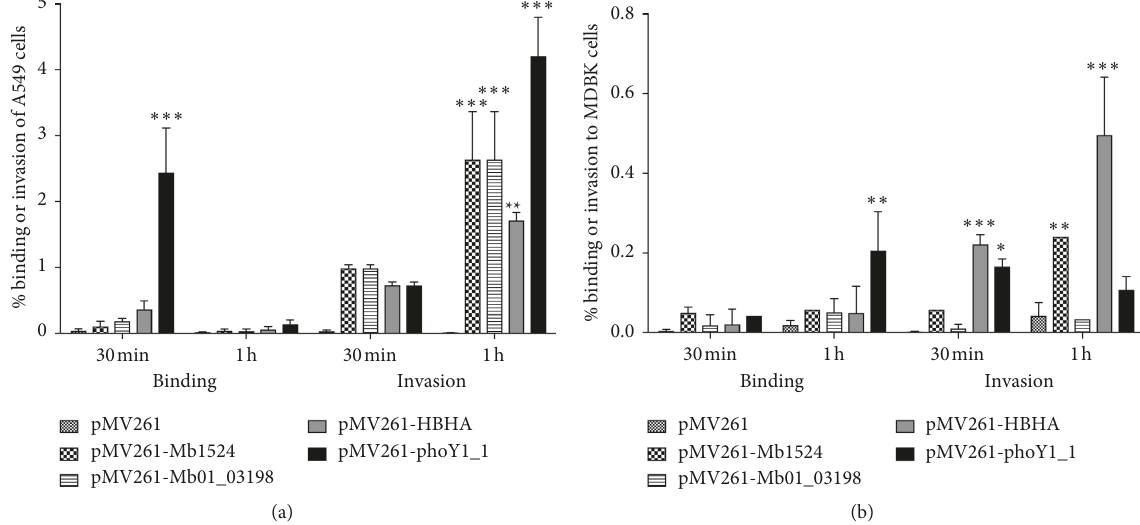
Figure 3: Binding and invasion assays of (a) A549 cells and (b) MDBK cells using M. smegmatis overexpressing pMV261-Mb1524, pMV261- Mb01_03198, pMV261-PhoU1, and pMV261-hbhA constructs. Results represent mean standard error of three independent experiments. ± Table 3: Infection of C57BL/6 mice with M. bovis BCG grown under laboratory and granuloma-like conditions. CFU/g a Infection/condition 3 days 2 weeks Lung Spleen Lung Spleen